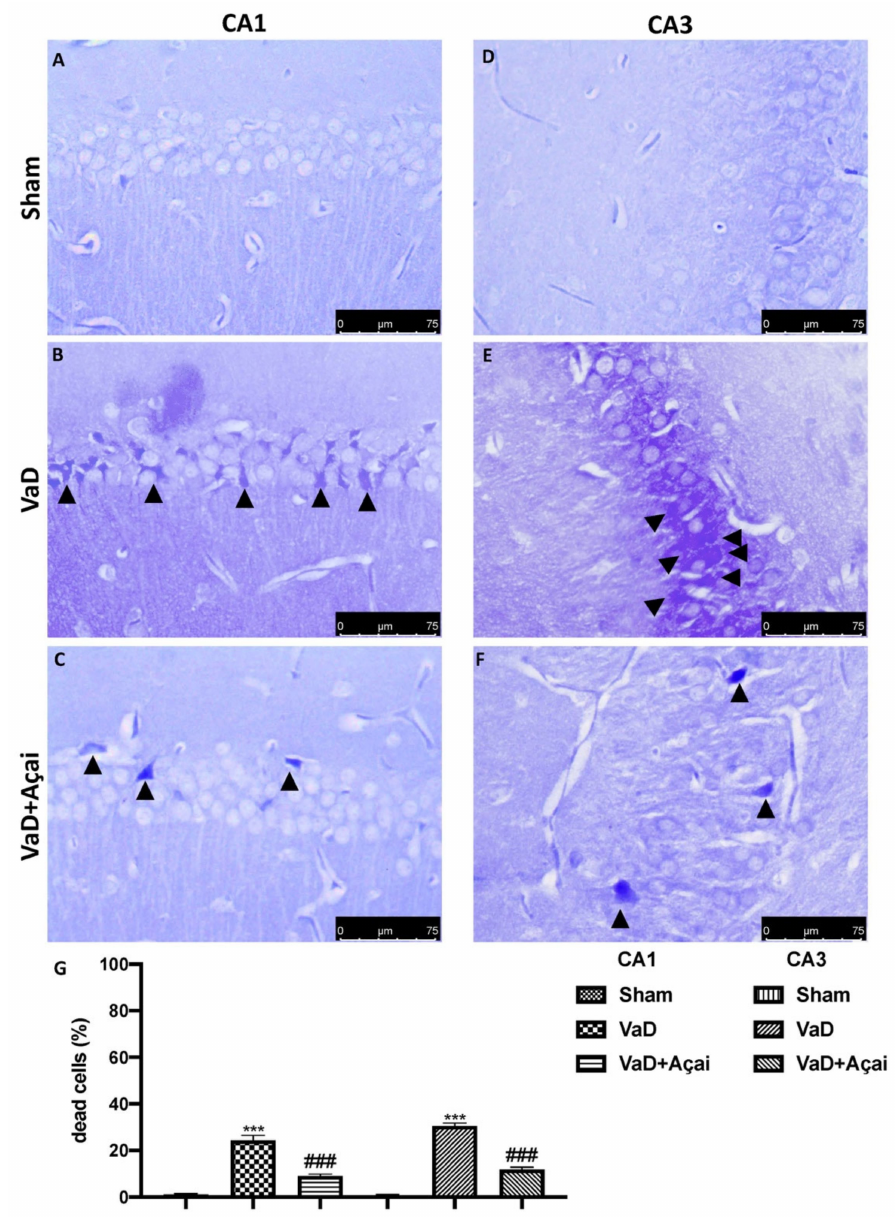
Figure 3. Açai berry limits neuronal hippocampal deaths. Hippocampal CA1 figure of Sham ( A ), VaD ( B ), Açai Berry ( C ); Hippocampal CA3 figure of Sham ( D ), VaD ( E ), Açai Berry ( F ); count of dead cells ( G ). Arrows indicate death neurons in both hippocampal sections. Figures are representative from at least three experiments. Values are means ± SEM of six mice for all groups. See manuscript for further details. *** p < 0.001 vs. sham; ### p < 0.001 vs.